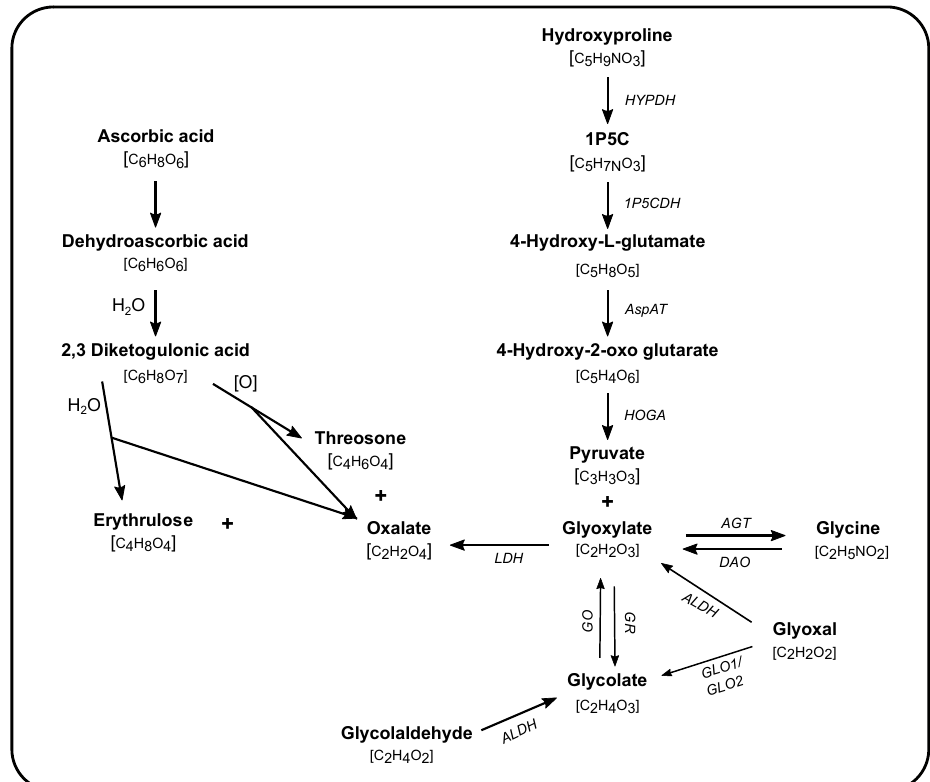
Figure 1. Pathways of endogenous oxalate synthesis. Synthesis of oxalate occurs via enzymatic (names in italics) and non-enzymatic reactions taking place in different subcellular compartments (cytosol, mitochondria, and peroxisome). The molecular formula is given in brackets underneath each compound. Glycolaldehyde is a product of fructose and xylitol metabolism. 1P5C: 1-pyrroline-3-hydroxy-5-carboxylic acid, LDH: lactate dehydrogenase, GO: glycolate oxidase, GR: glyoxylate reductase, AGT: alanine:glyoxylate aminotransferase, DAO: D-amino oxidase, ALDH: